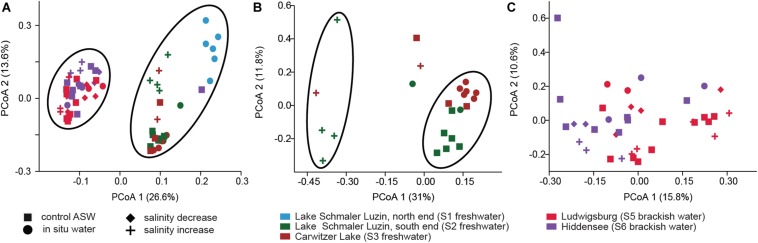
Principal Coordinate Analysis based on Bray–Curtis dissimilarity of bacterial community composition on OTU level. (A) All samples, (B) freshwater samples from S2 (dark green) and S3 (brown) at ambient conditions (filled dot) and control conditions (filled square) and after saline manipulation (plus). (C) Brackish samples from S5 (pink) and S6 (purple) at ambient conditions (filled dot) and control conditions (filled square) and after saline manipulation (plus—salinity increase and filled diamond—salinity decrease).